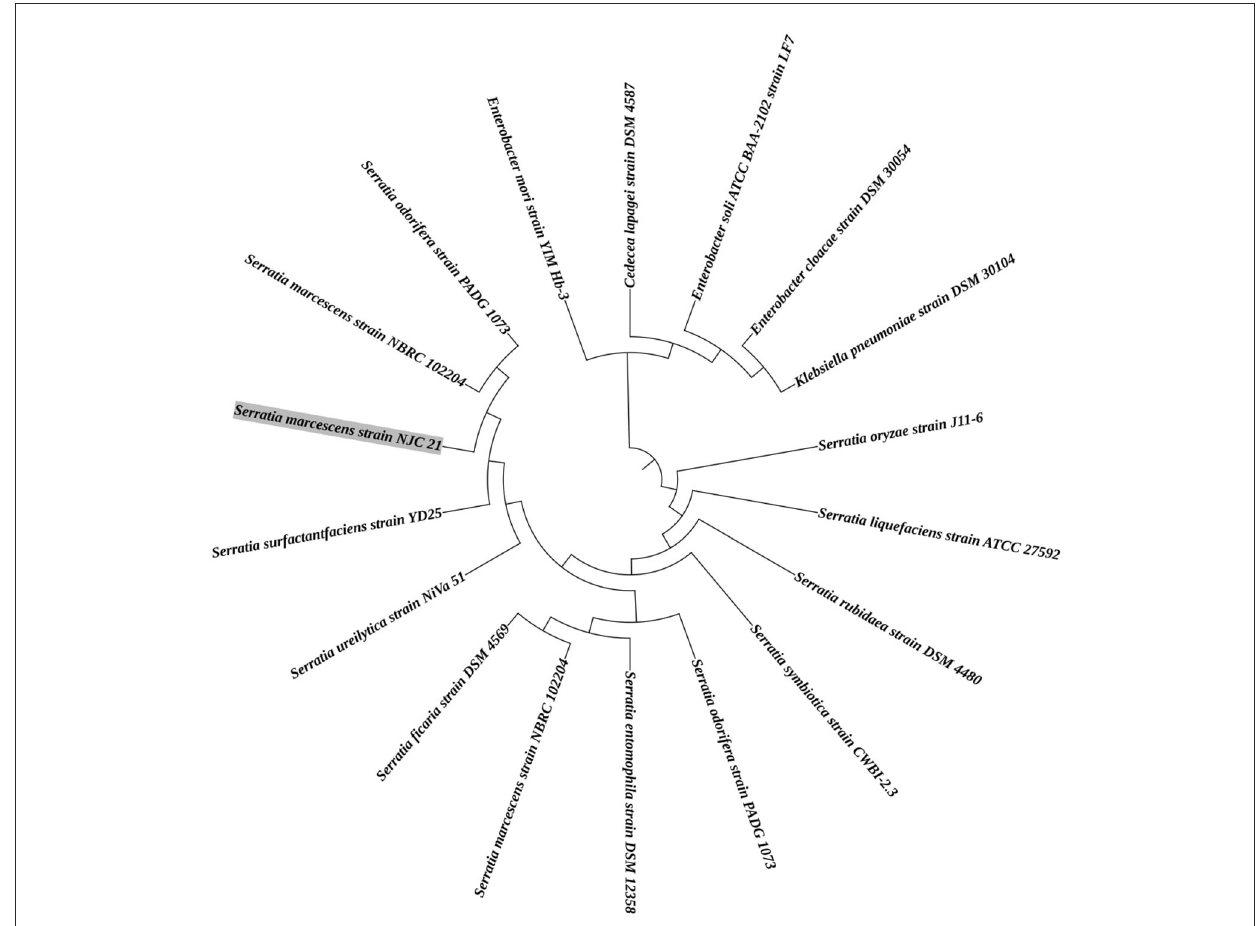
FIGURE3 Phylogenetic tree of Serretia marscences – NJC 21 (OP 283923).